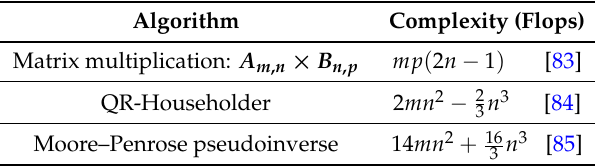
Table 6. Complexity of various algorithms.